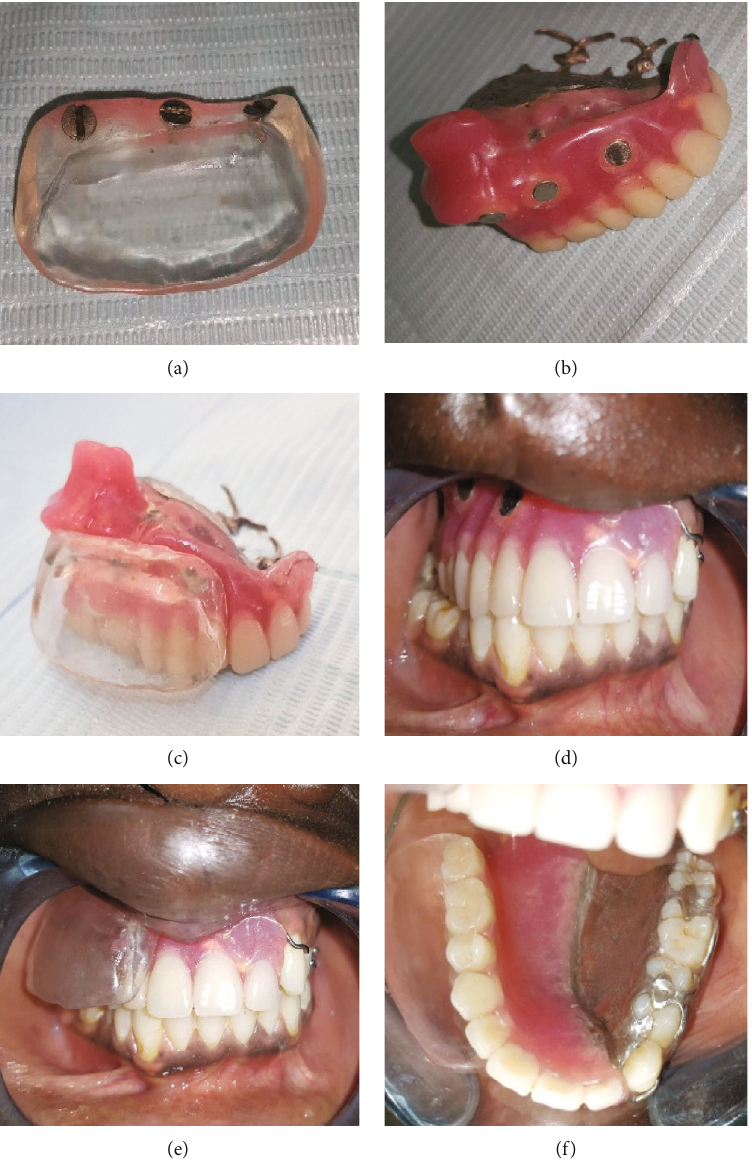
Figure 3: (a) Magnets attached to the removable part of the plumper; (b) magnets attached to the de fi nitive obturator; (c) de fi nitive obturator with plumper parts attached together, (d) intraoral view showing magnets attached to the de fi nitive obturator; (e) intraoral view of the plumper; (f) occlusal view of the view of the